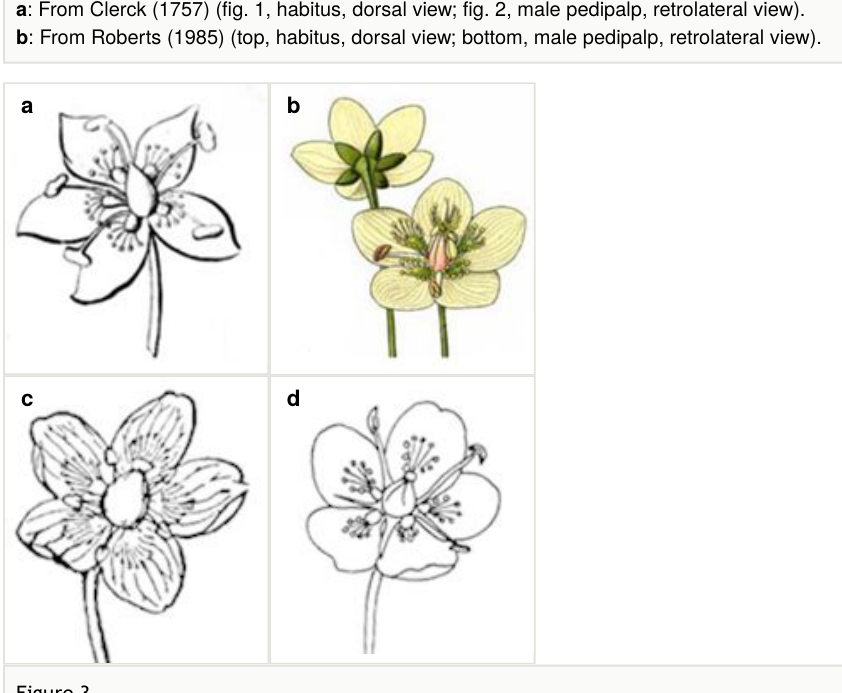
Figure 3. Taxonomic illustrations depicting the fl ower anatomy of the European marsh grass Parnassia palustris (Plantae: Angiosperms: Celastrales: Celastraceae). a : From Linnaeus